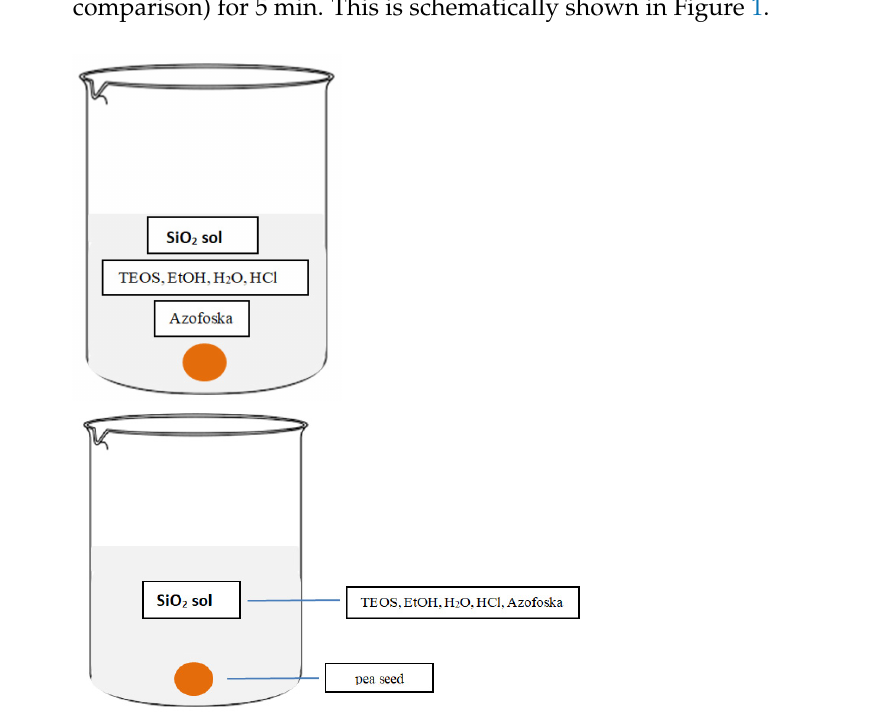
Figure 1. Deposition of the SiO 2 -Azofoska coating on pea seeds.